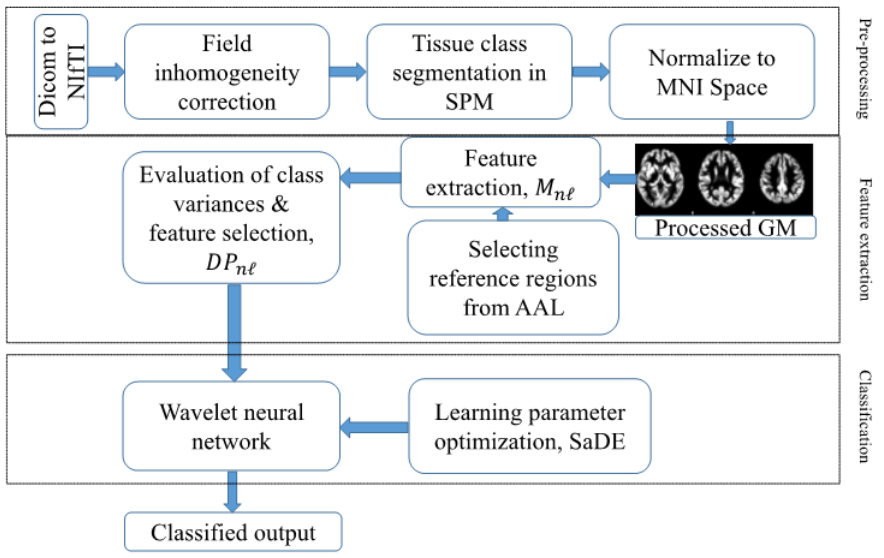
Figure 1. Systematic flow diagram of the proposed approach.